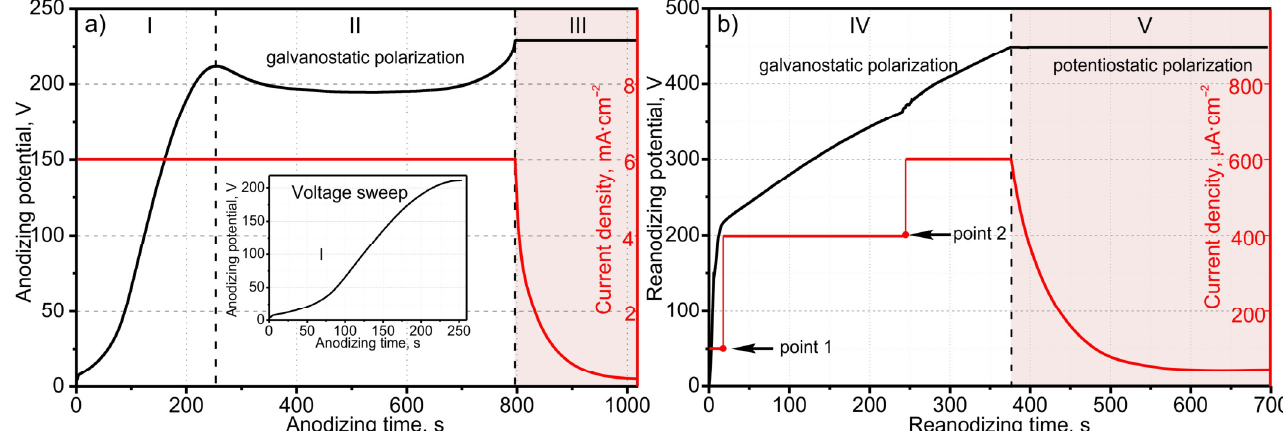
Figure 5. Current- and voltage-time responses grown from the second-level column-like 3D nanofilm during the PAA anodizing ( a ) in 0.2 M aqueous C 4 H 6 O 6 followed by reanodizing ( b ) in 0.5 M aqueous H 3 BO 3 and 0.05 M aqueous borax of an Al (2000 nm)/hexagonally-packed Ta (500 nm) bilayer sputter-deposited on the first-level column-like anodic niobia. The marked stages are: I—nucleation and beginning of a steady-state growth of pores, II—steady-state pore growth (at 200 V), III—complete alumina, nucleation, and development of tantala embryos (Figure 2f), IV—galvanostatic reanodizing the Ta underlayer up to 450 V (Figure 2g), V—galvanodynamic-potentiostatic polarization at 450 V (current decay). The profiles have been presented in two separate panels, for the sake of clarity.